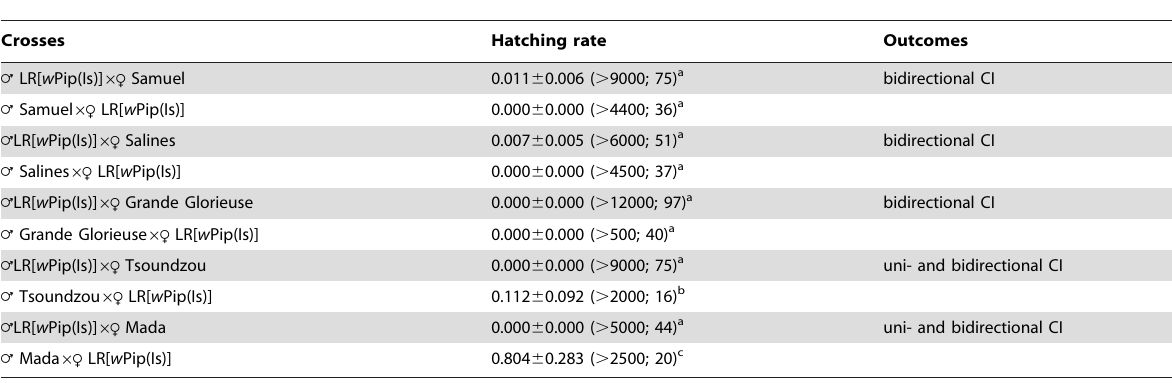
Table 4. Reciprocal crosses between LR[ w Pip(Is)] line and field specimens.